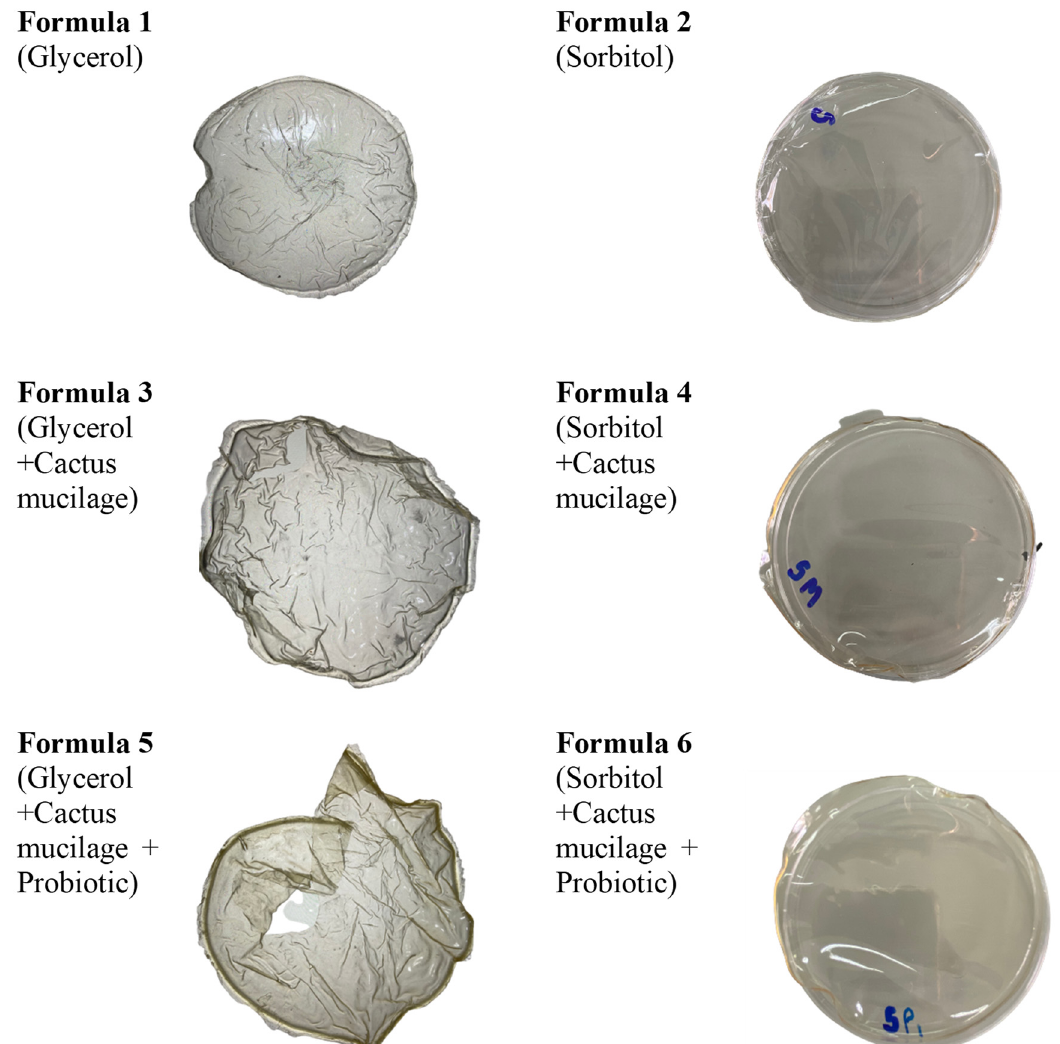
Figure 1. Film characteristics among the 6 formulas.